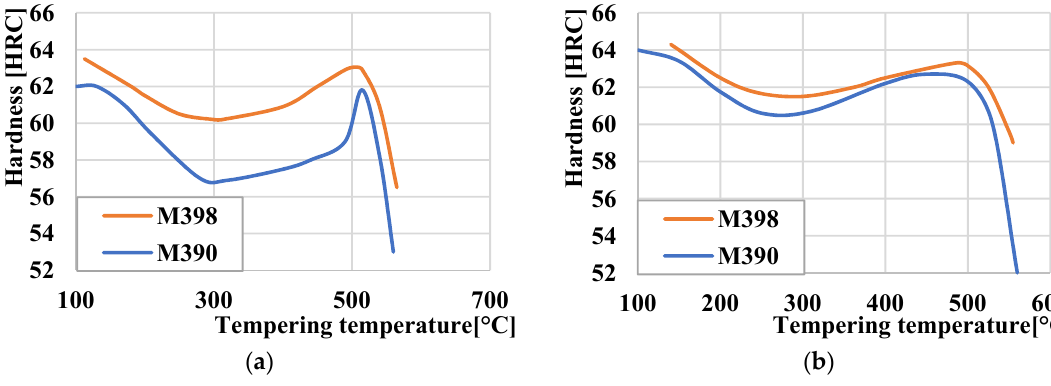
Figure 4. Tempering diagrams: ( a ) without deep freezing; ( b ) with deep freezing.